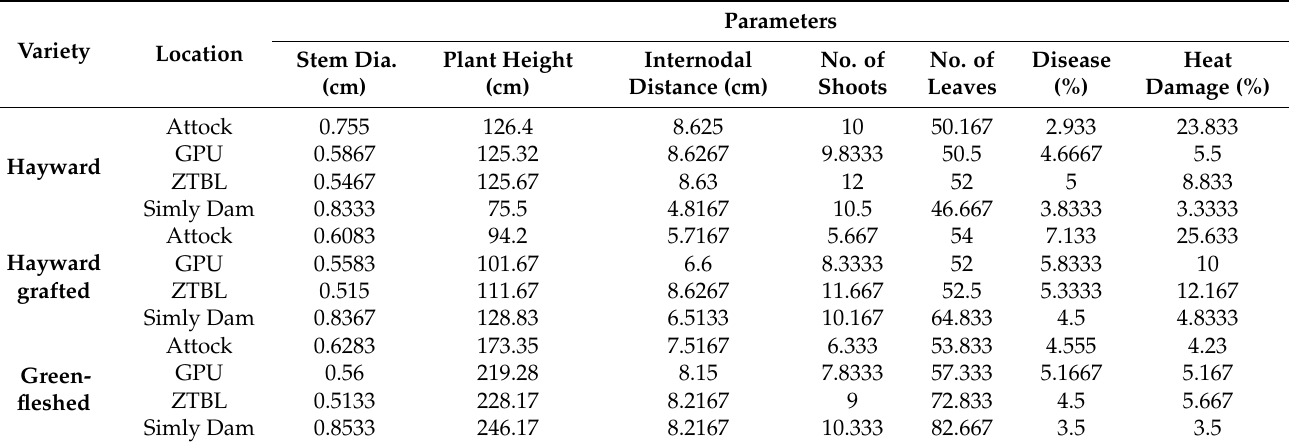
Table 3. Growth parameter analysis of three varieties (Hayward, Hayward grafted, and green-fleshed) at Attock, GPU, ZTBL, and Simly Dam.